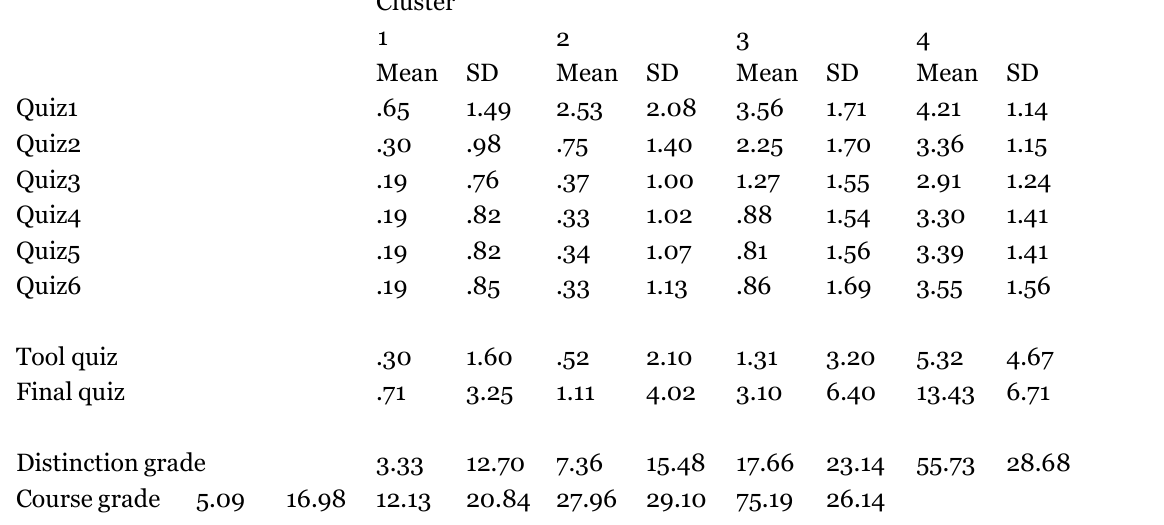
Mean (and SD) Quiz Scores and